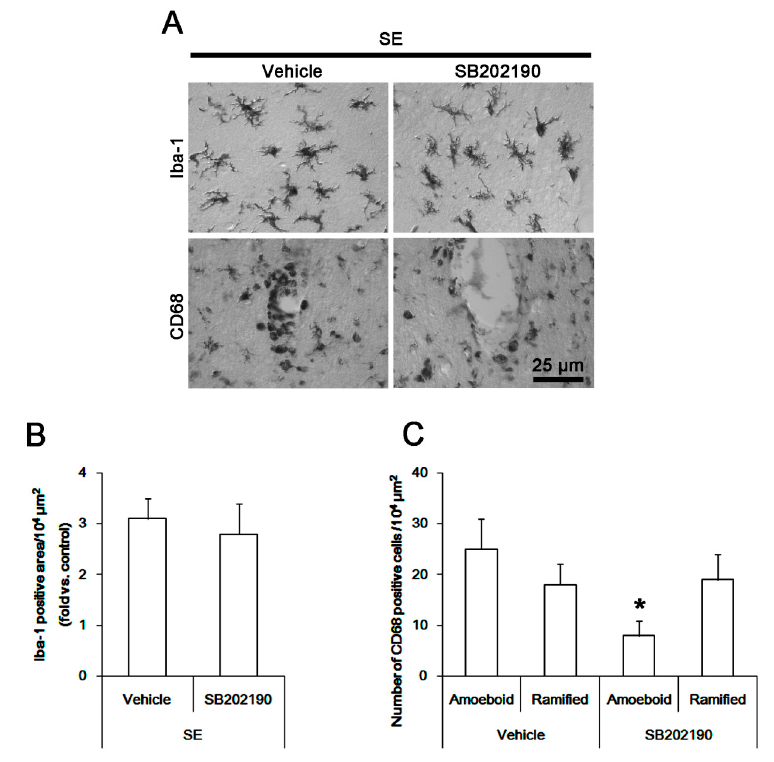
Figure 6. The e ff ect of SB202190 on microglia activation and monocyte infiltration in FPC following SE . Although SB202190 does not influence Iba-1 microglia transformation, it reduces the number of CD68 amoeboid cells without altering that of CD68 hyper-ramified cells following SE. (A) Representative images for Iba-1 and CD68 positive cells. (B,C) Quantification of the e ff ect of SB202190 on Iab-1 positive area ( B ) and the number of CD68 amoeboid and ramified cells ( C ) following SE. Error bars indicate SEM ( * p < 0.05 vs. control- or vehicle-treated animals; n = 7, respectively).